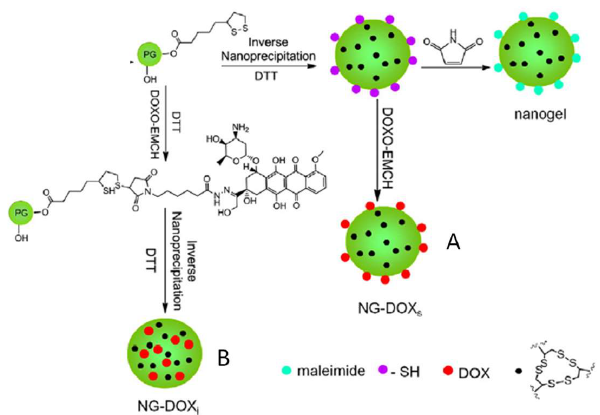
Figure 3. Hydrogel nanoparticles generated by the crosslinking of PEGs terminated with reduced dithiolane that can form disulfide bonds. Maleimide-tagged doxorubicin can be attached either at the surface of the gel particles ( A ) or in the interior ( B ) depending on the order of gel crosslinking and drug conjugation. Image modified with permission from [34]. Copyright 2014 Elsevier.